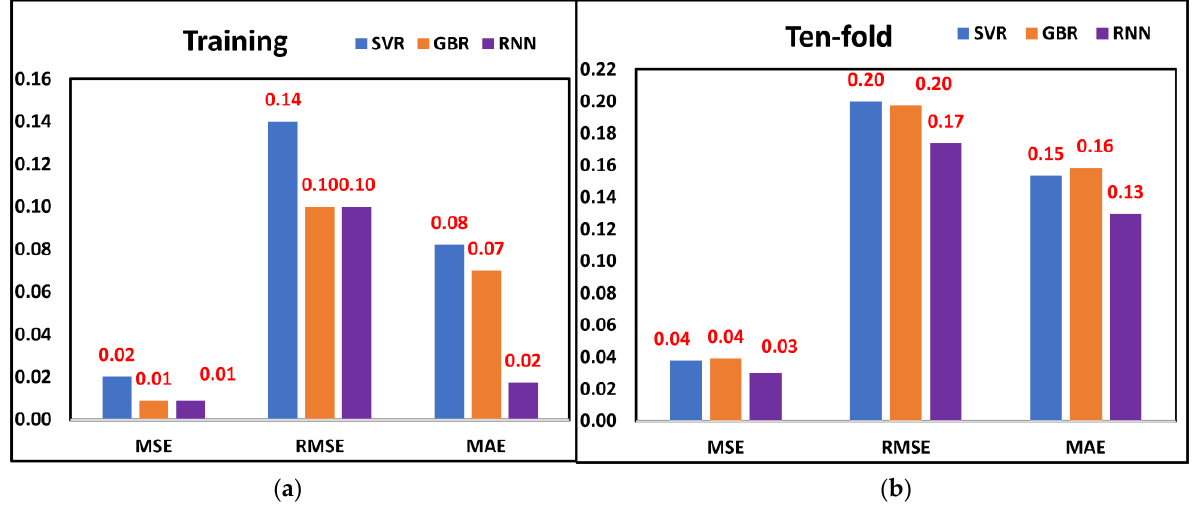
Figure 8. Prediction errors from genetic algorithm selected features ( a ) Training ( b ) Ten-fold.